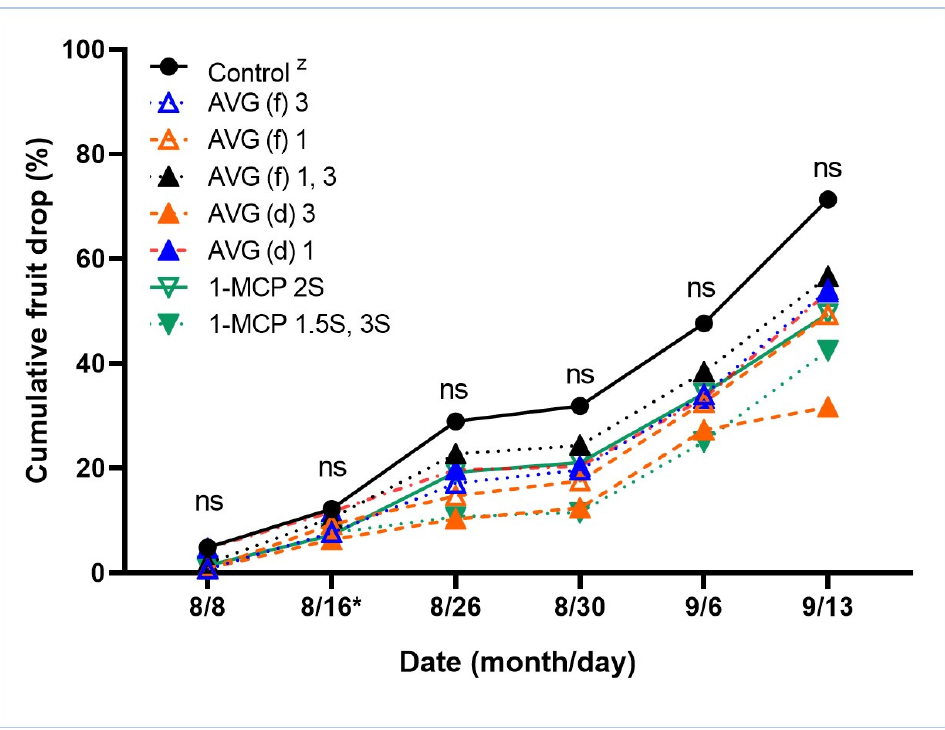
Figure 2. Effects of AVG and 1-MCP on preharvest fruit drop of ‘Brookfield Gala’ apples in 2019. Z, AVG was applied at full-rate (f, 130 mgL − 1 ) or double rate (d, 260 mgL − 1 ); 1-MCP was applied at a starch pattern index (SPI) = 2; d, double of 1-MCP at SPI = 1.5 and 3; numbers in each treatment indicate the numbers of weeks before anticipated harvest (WBAH) when the treatment was conducted; *, date of harvest.